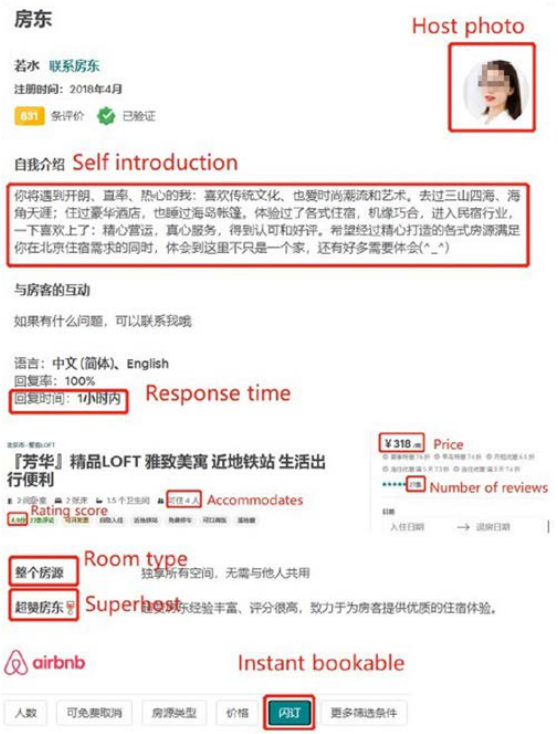
Figure 2. Example of the variables.